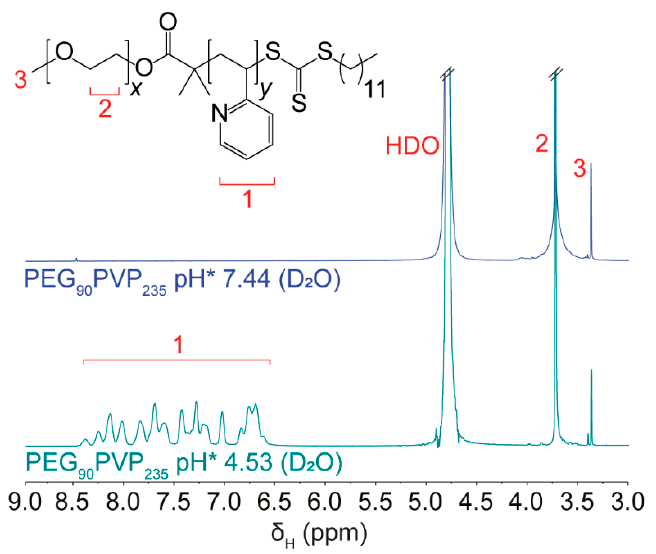
Figure 2. 1 H NMR spectra (D 2 O, 500 MHz, 23 °C) of PEG 90 PVP 235 micelles prepared in deuterated PBS at pH* 7.44 (1 mg·mL − 1 ) and then adjusted to pH* 4.53.